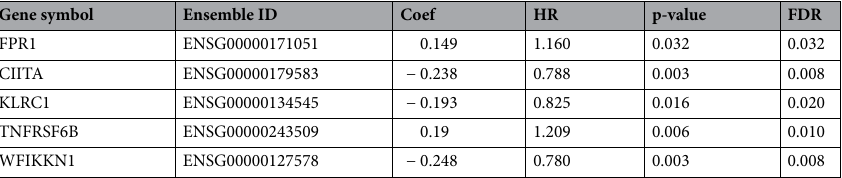
Table 2. Information of the five PIRMGs in the signature. Coef regression coefficient calculated by multivariate Cox regression analysis, HR hazard ratio, CI confidence interval, FDR p-values adjusted in FDR method.